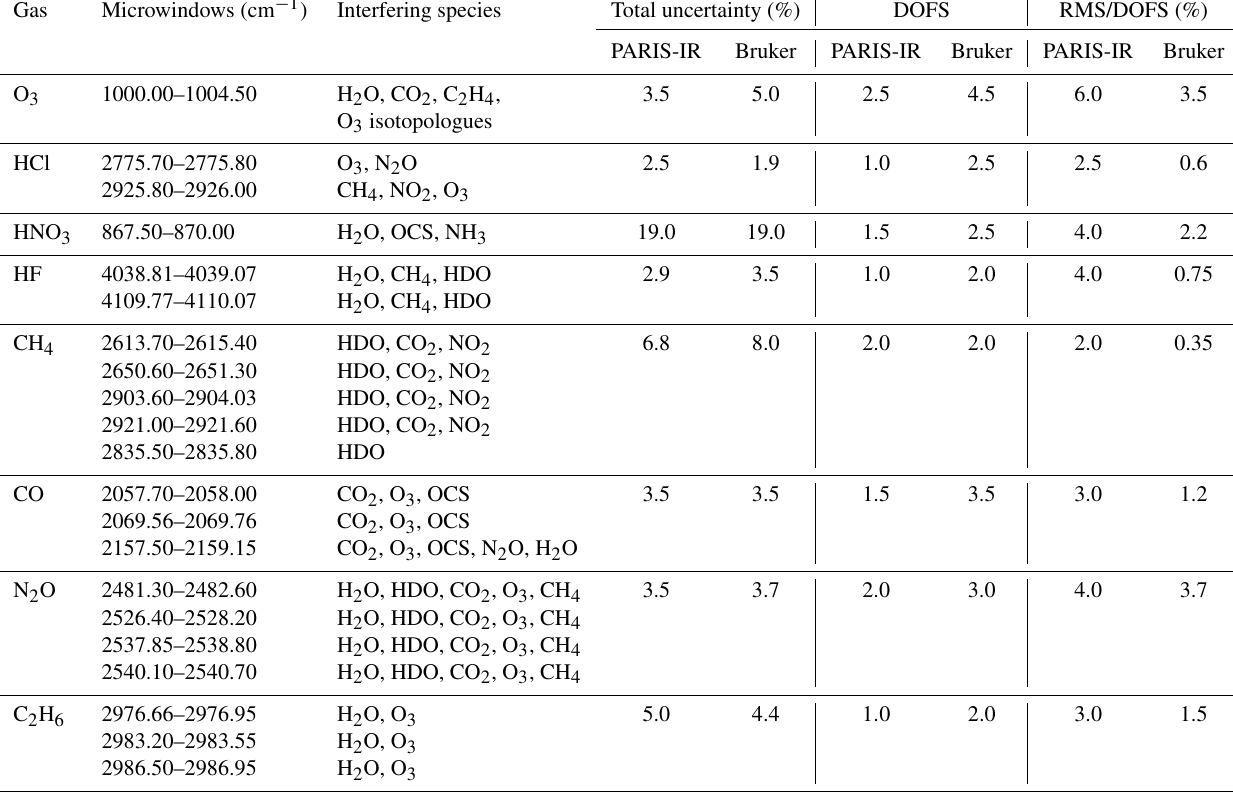
Table 1. Summary of the parameters used for the eight trace gas retrievals (retrieval microwindows and interfering species) with an estimate of the total uncertainty of the retrieval ( ± in %), degrees of freedom for signal (DOFS), and the root-mean-square (RMS) DOFS values (in %) used to filter the dataset of the PARIS-IR and the Bruker 125HR retrievals. In each retrieval, a single or multiple microwindows are fitted simultaneously as listed in the table below. For the calculation of the total uncertainty and contributions, see the description given in the